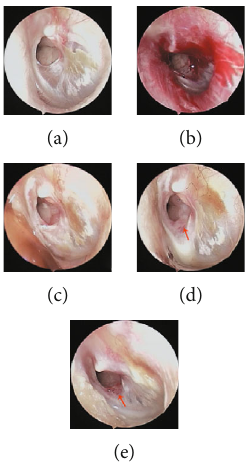
Figure 1: (Patient 1): a 37-year-old woman with COM and a left medium-sized perforation. Pretreatment perforation (a), freshened edges (b), and edges after 2 (c), 7 (d), and 12 (e) weeks of treatment. Red arrows indicate a moderate granulation reaction.